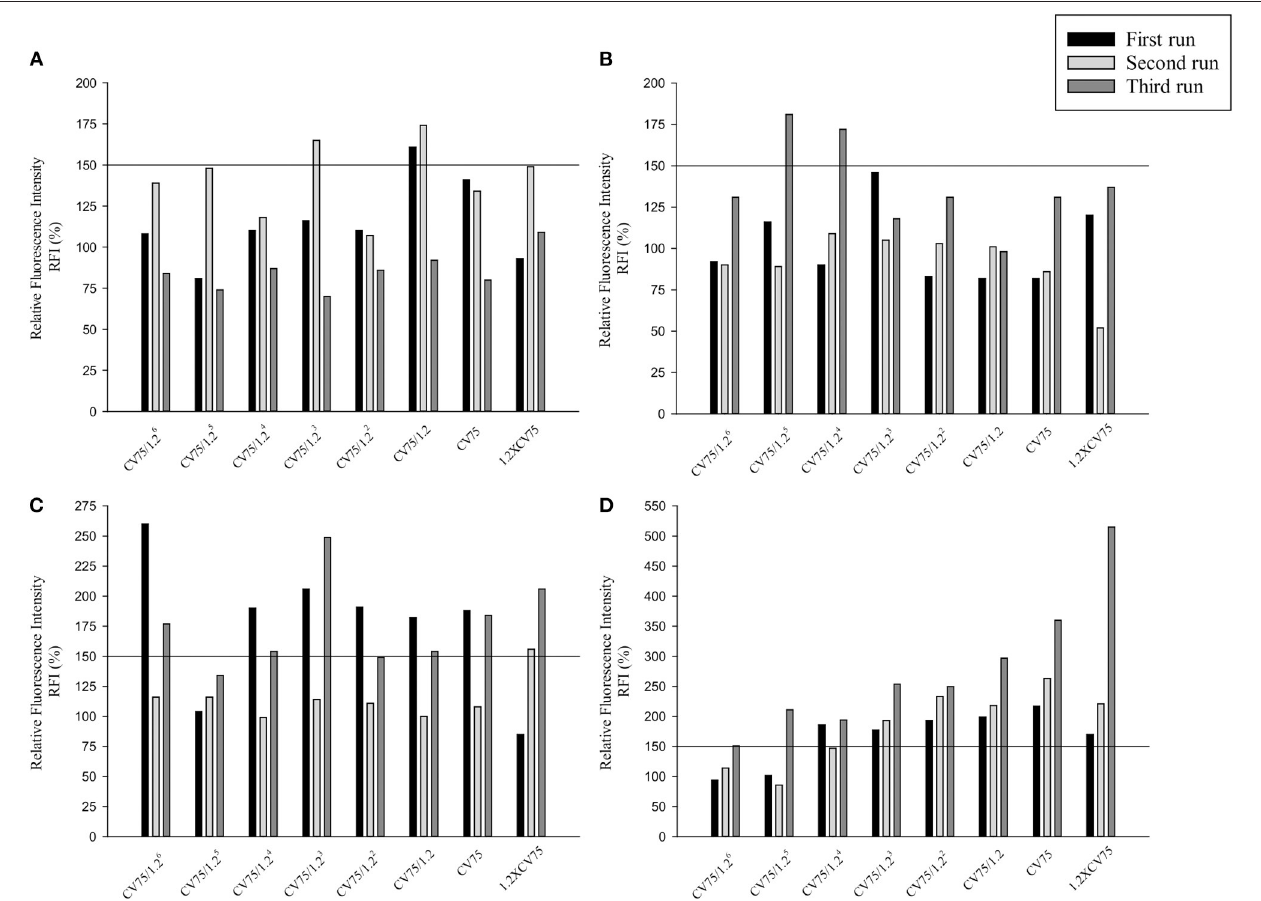
FIGURE 1 | Relative Fluorescence Intensity (RFI) data of three different runs for CD86 of (A) 20nm AgNPs (B) 50nm AgNPs (C) 80nm AgNps and (D) ZnO NPs at different concentrations (1/1.2 6 × CV75, 1/1.2 5 × CV75, 1/1.2 4 × CV75, 1/1.2 3 × CV75, 1/1.2 2 × CV75, 1/1.2 × CV75, CV75, 1.2 × CV75). RFI were obtained by calculating the percentage of CD86 Mean Fluorescence Intensity (MFI) of NPs treated cells compared to CD86 MFI of solvent/vehicle treated cells after reduction of CD86 MFI of isotypes of respective